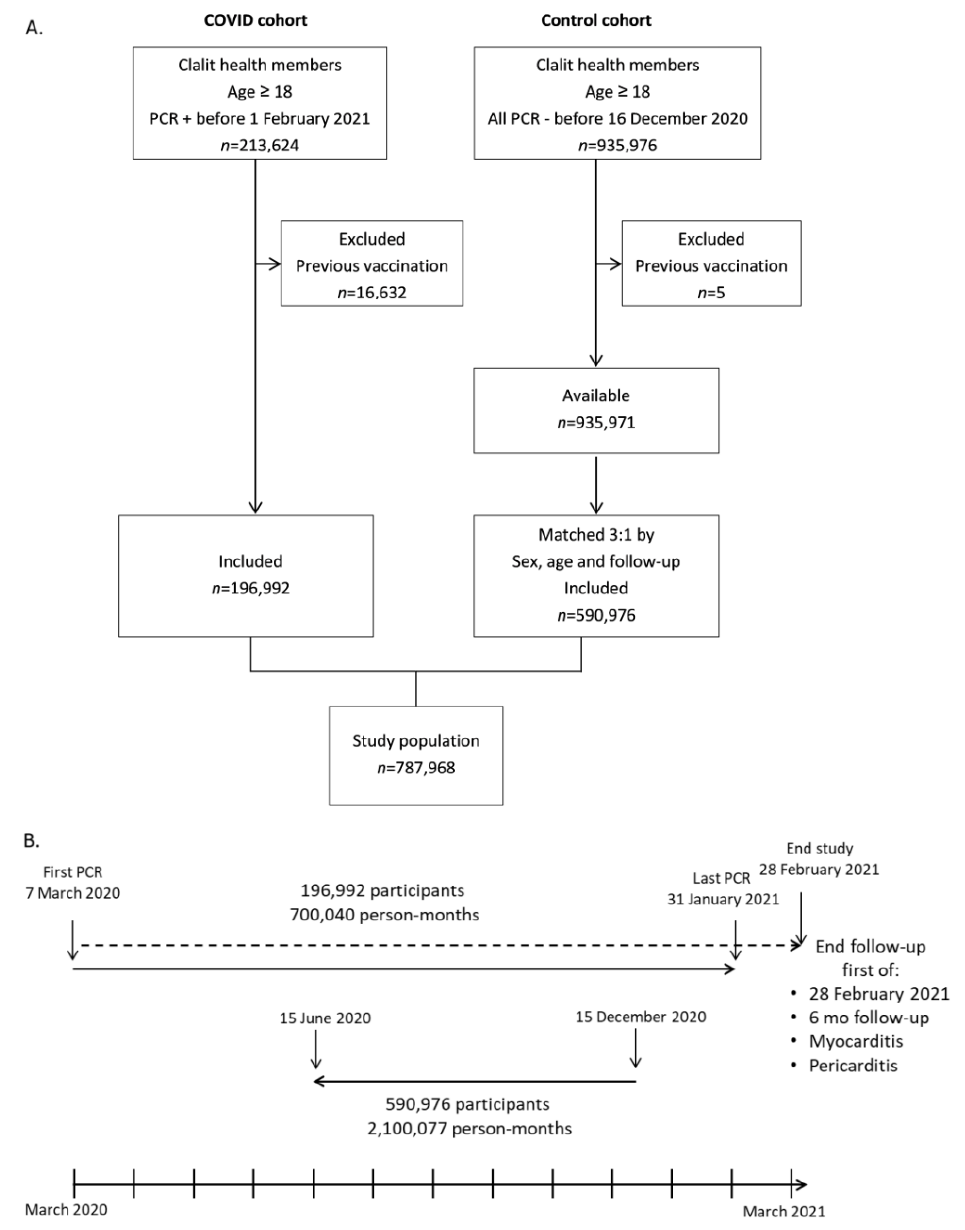
Figure 1. Study profile, design and timelines. ‘clalit’ = Clalit Health Services. Vaccination = COVID-19 vaccination. PCR − /+ = negative/positive COVID-19 PCR. ( A ). Flowchart of patient selection in COVID and control cohorts. ( B ). Research timeline from first PCR in 7 March 2020 to the end of study (lower part). The COVID cohort is depicted in the upper part, and the matching period of the control cohort is depicted in the middle.